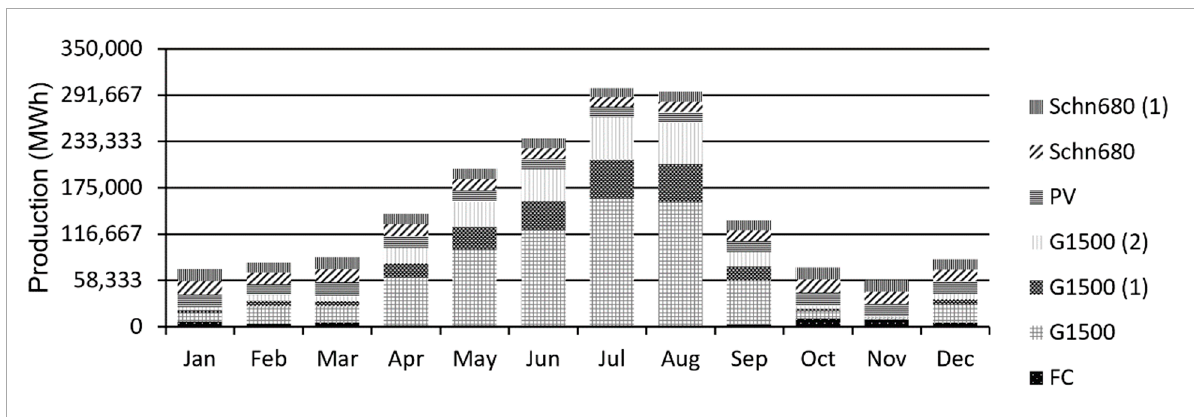
Figure 6. Monthly average electric energy production from renewable sources.